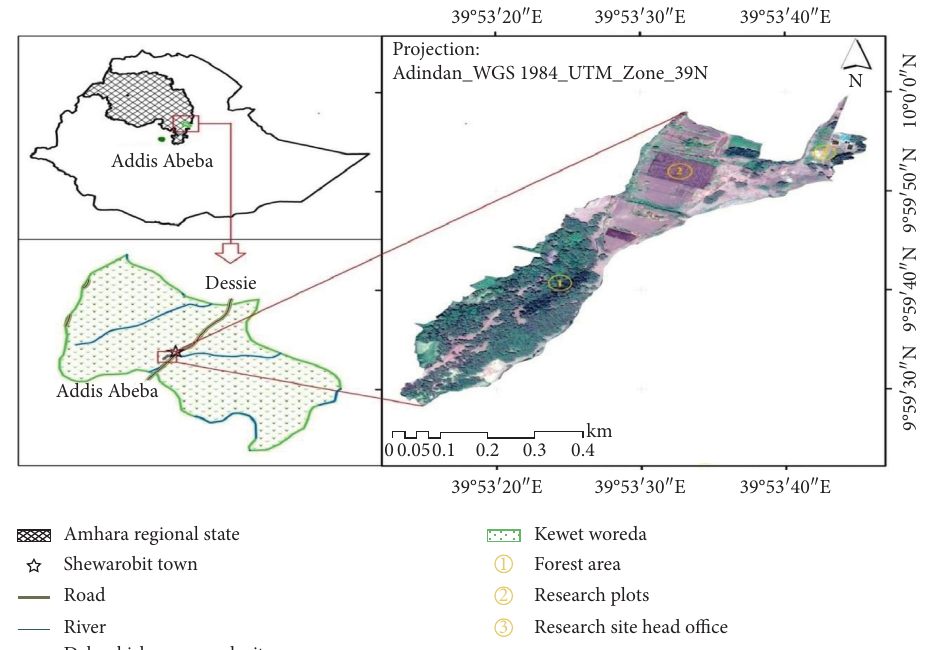
Figure 1: Map of the study